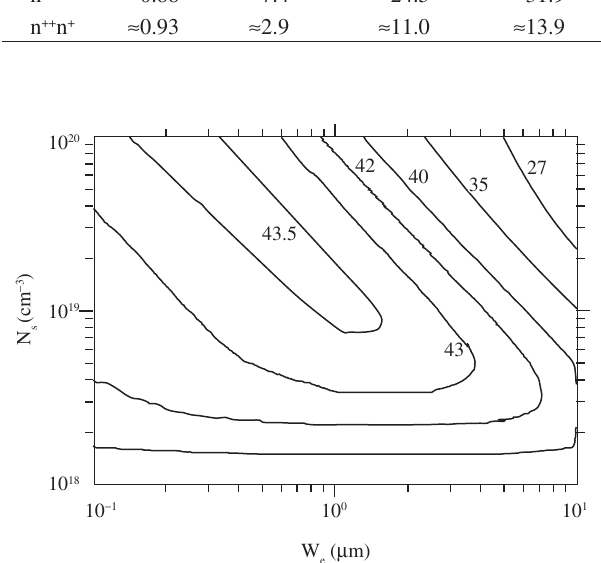
Figure 5. Total emitter recombination, J doping concentration, N are for homogeneous and DD emitters, respectively.